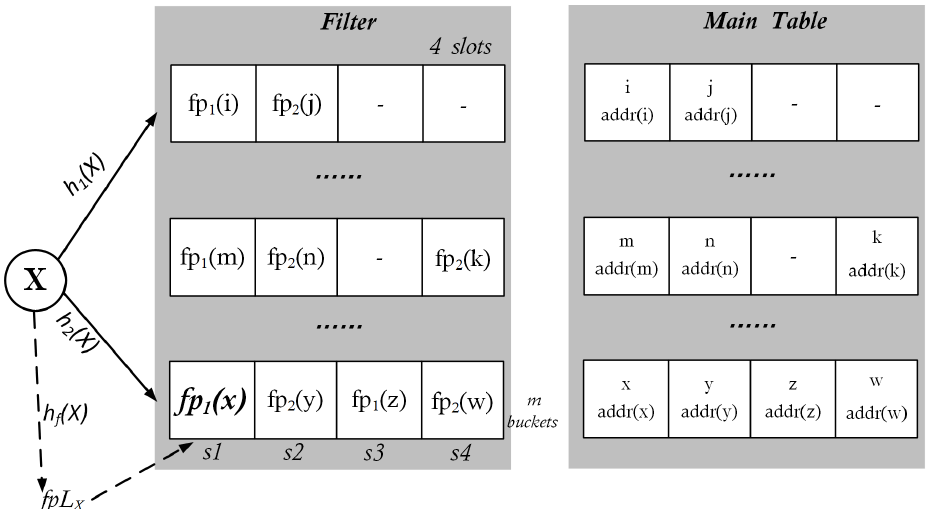
Figure 4. Correspondence between SACF fingerprints and main table